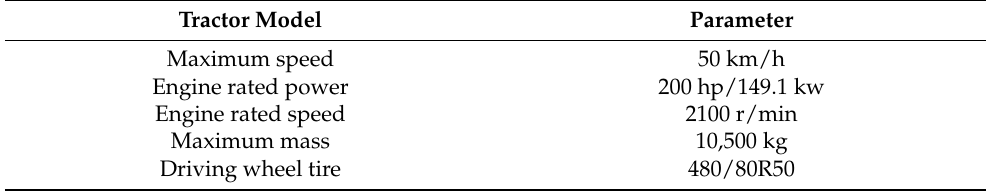
Table 1. The basic parameters of tractor.